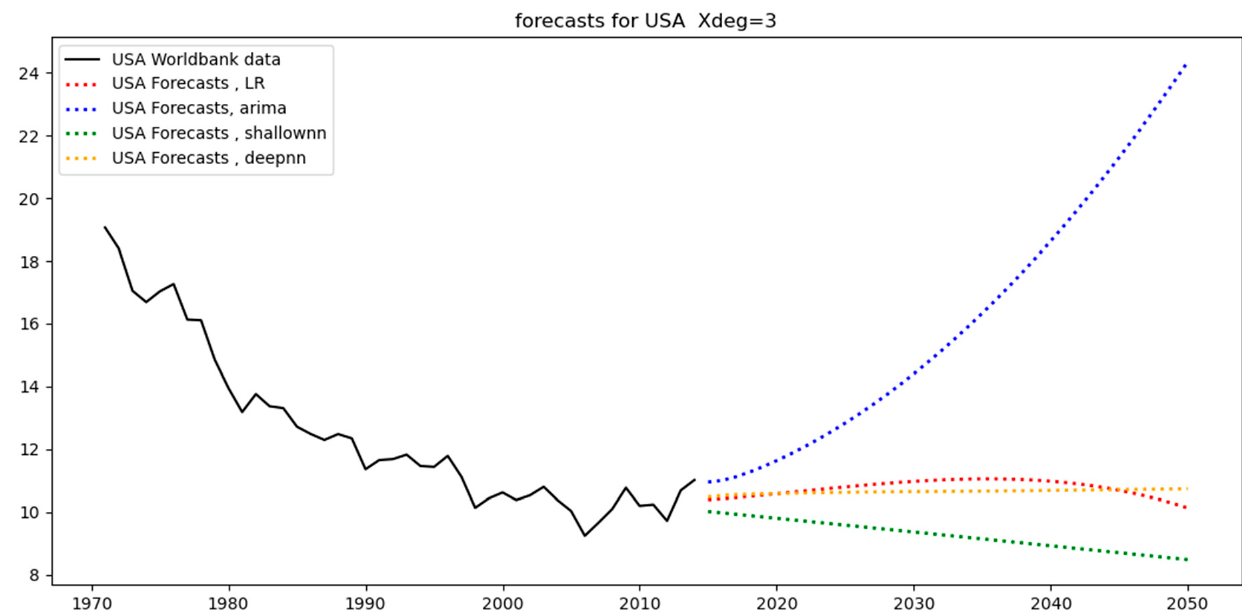
Figure 15. Forecasts for the USA, using linear regression (LR), ARIMA, shallow neural networks (shallownn), and deep neural network (deepnn) models (third-degree polynomial).